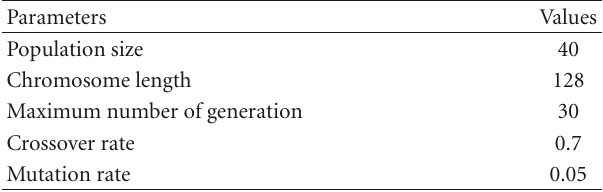
Table 1: Parameters of genetic